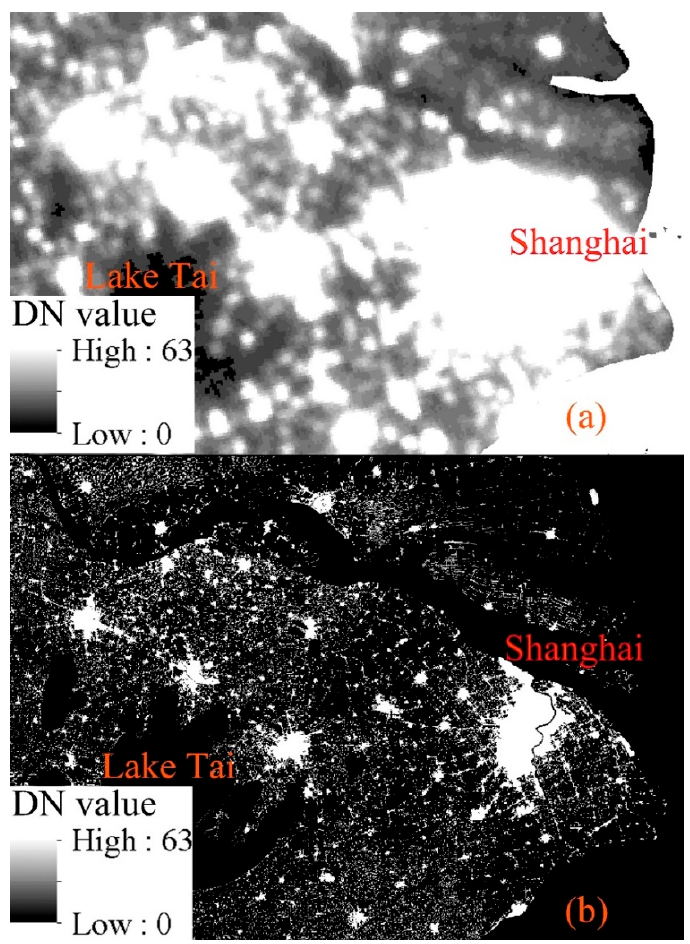
Figure 2. The digital number (DN) values of ( a ) raw and ( b ) enhanced DMSP/OLS